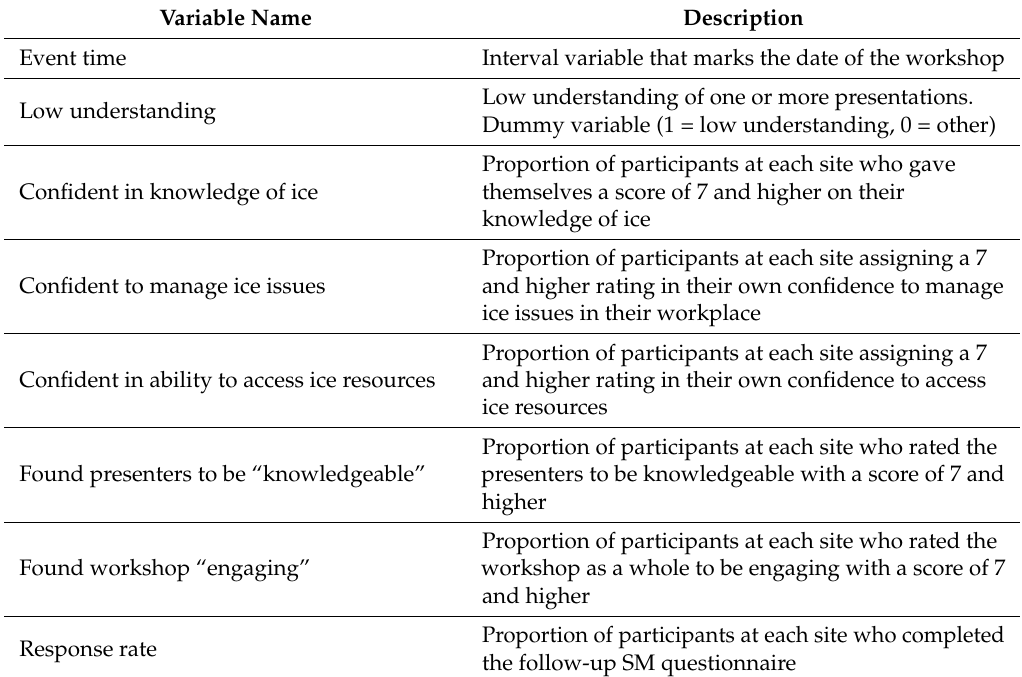
Table 2. Description of